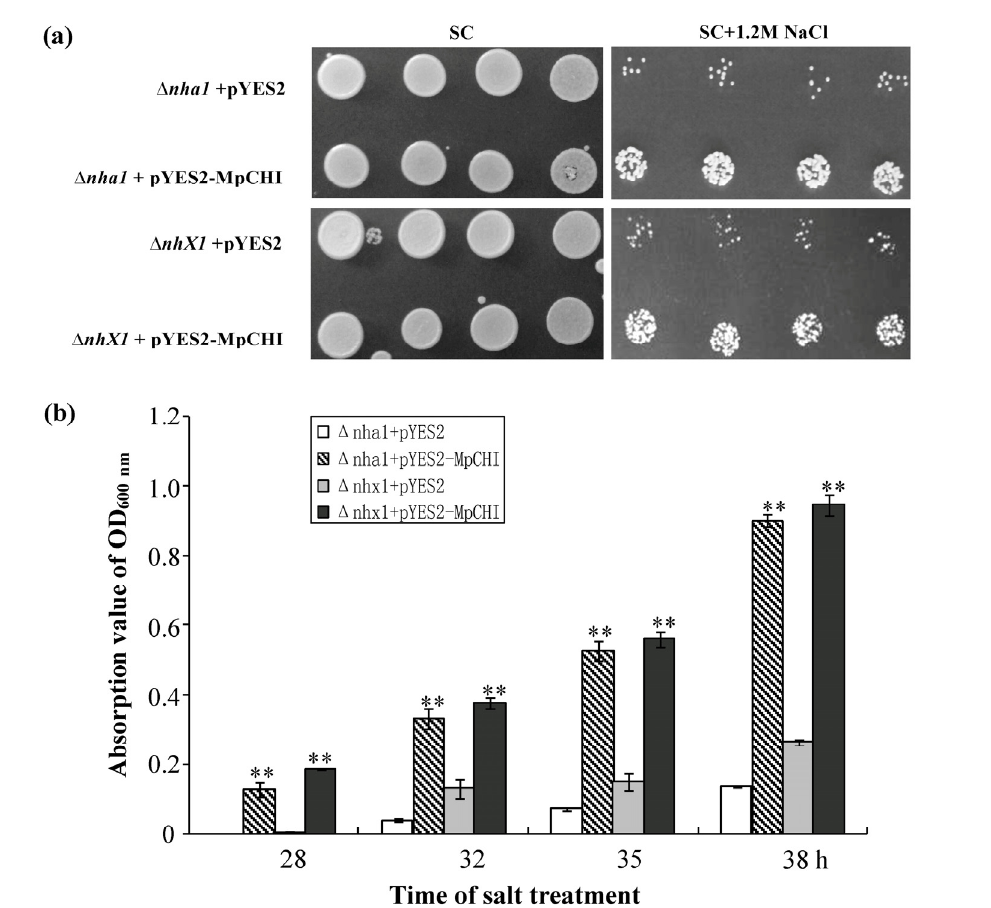
Figure 5. Enhanced salt tolerance in pYES2 - MpCHI transformed yeast